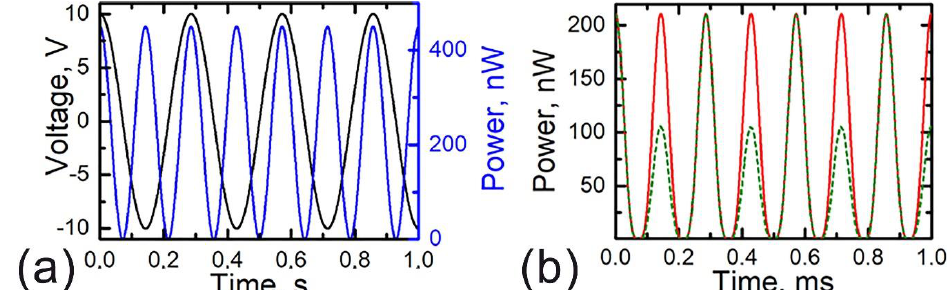
Figure A2. Temporal dependence of ( a ) AC voltage and Joule power generated near a tip-sample contact with a linear I−V curve. ( b ) Temporal dependence of power generated near the contact for a non-linear anti-symmetric I−V curve with A + /A − = 1 (red line) and an asymmetric I−V curve with A + /A − = 2 (green dotted line).